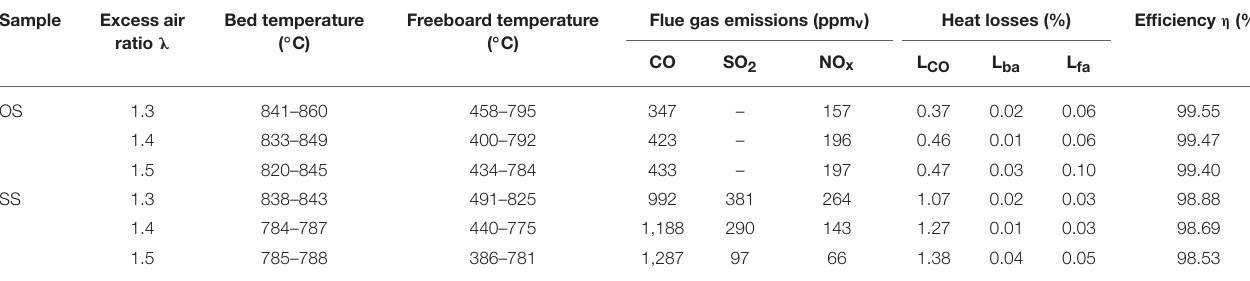
TABLE 2 | Fluidized bed combustion performance of fuels at different excess air ratios and feed rate 0.72 kg/h. Sample Excess air ratio λ